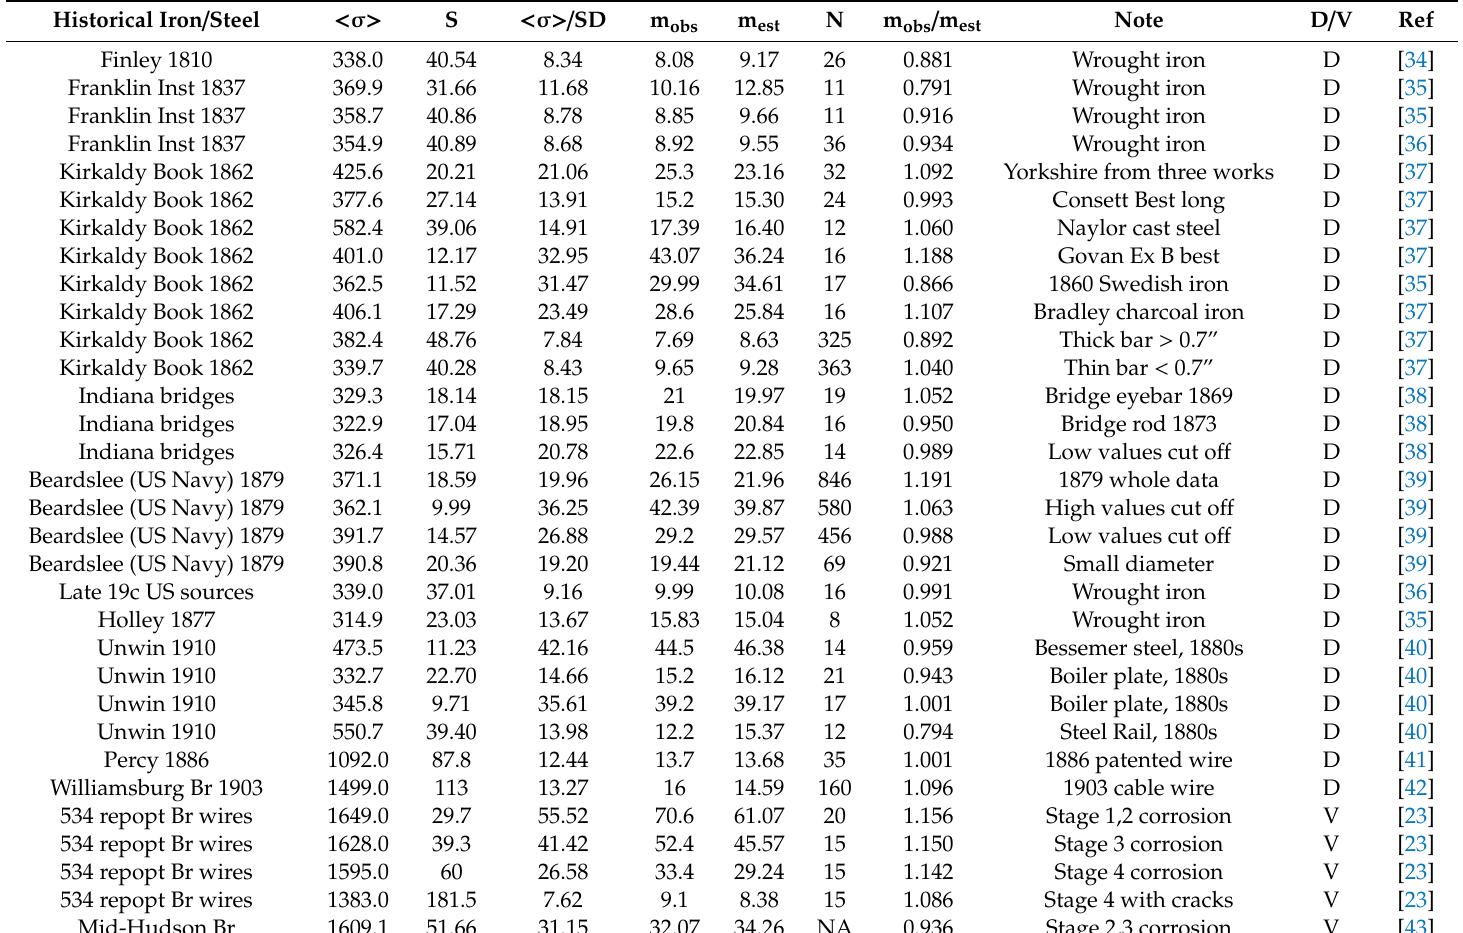
Table 2. Listing of data for wrought iron and steel of the 19th century to the early 20th